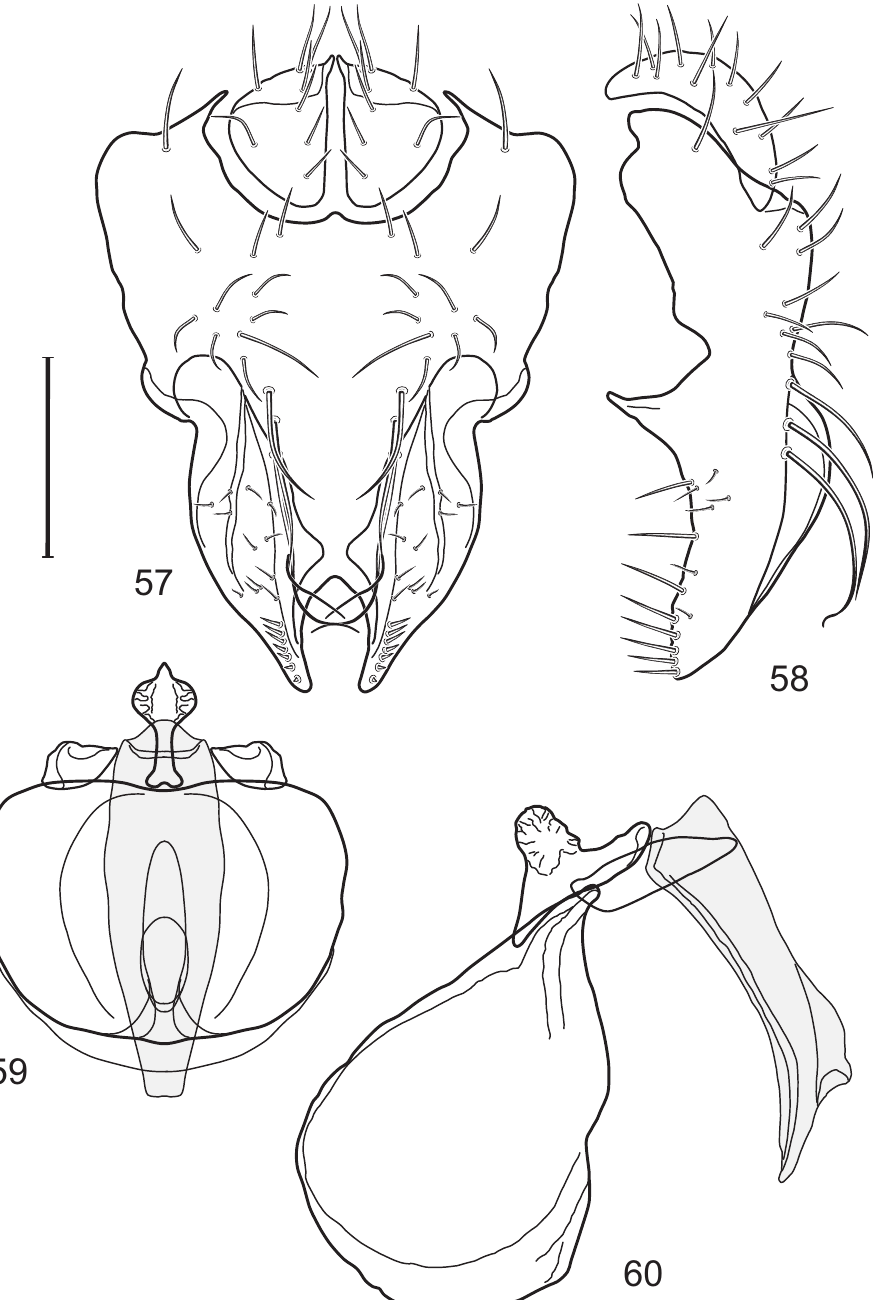
Figures 57–60. Hydrochasma williamsae sp. n. (USA. New Mexico. Grant: Mimbres River) 57 epan- drium and cerci, posterior view 58 same, lateral view 59 internal structures of male terminalia (aedeagus [shaded], phallapodeme, gonite, hypandrium), ventral view 60 same, lateral view. Scale bar = 0.1